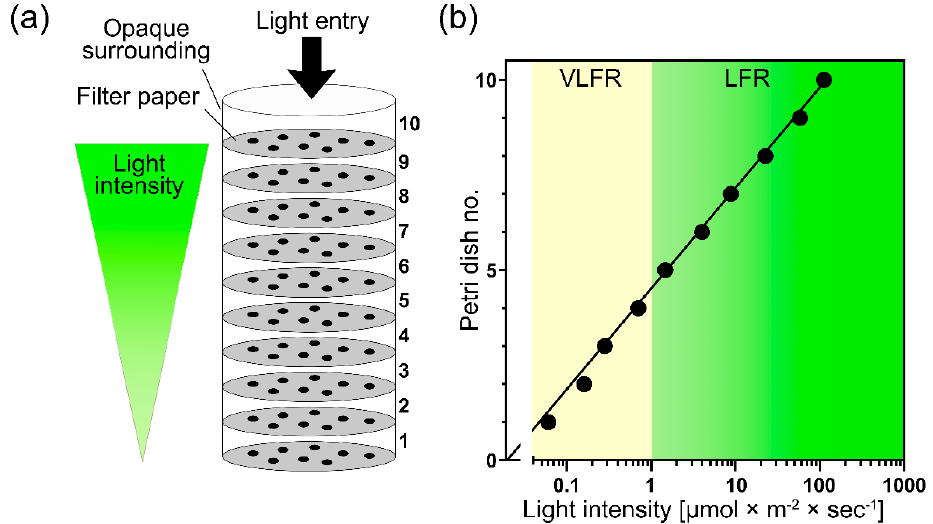
Figure 2. The effects of gas-plasma-activated water (Air GPAW) and GA biosynthesis inhibition on the time courses of Nicotiana tabacum testa rupture (TR) and endosperm rupture (ER). ( a ) Effect of the GA biosynthesis inhibitor paclobutrazol (PAC) and GPAW on TR and ER in continuous white light (ca. 111 µ mol m − 2 s − 1 ). ( b ) The effects of GPAW, GA and PAC treatment on the TR and ER of tobacco seeds imbibed in darkness. Results are shown as mean ± SEM of three petri dishes each with 40 seeds imbibed at 20 ◦ C.